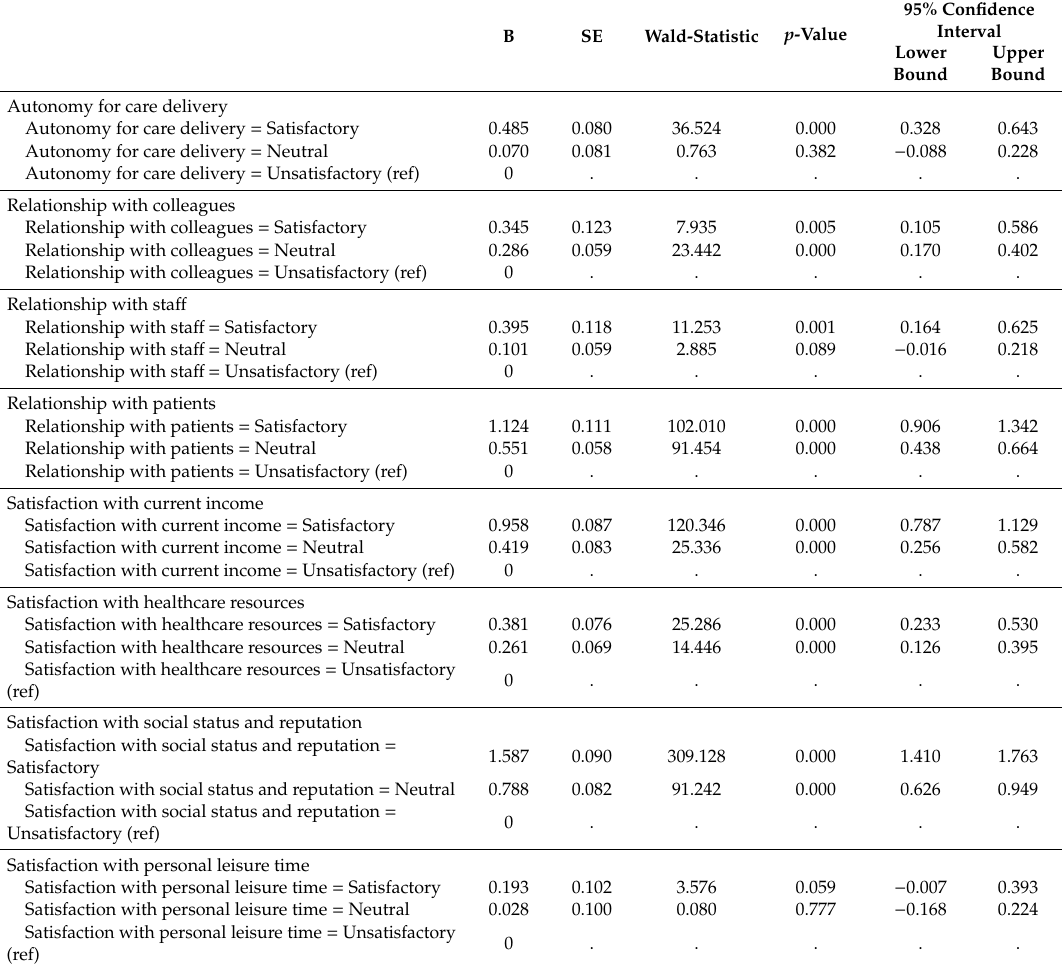
Table 4. Ordinal logistic regression of Korean physician job satisfaction by general characteristics and medical environment characteristics.